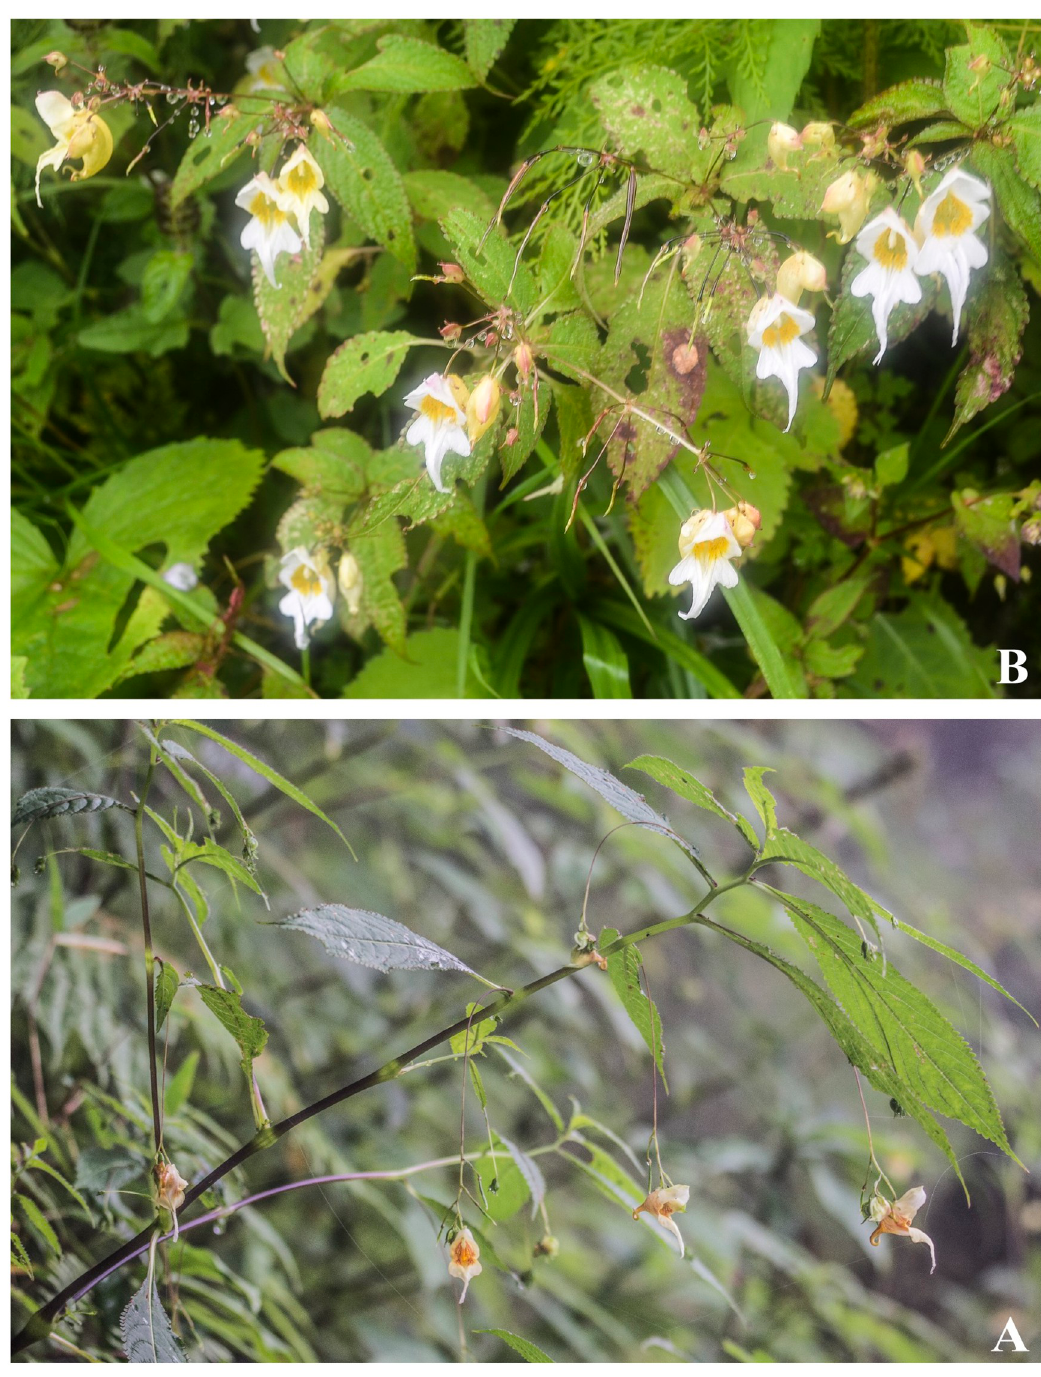
Fig 15. A, Impatiens harae ; B. Impatiens urticifolia . Photographs by Bhakta Bahadur